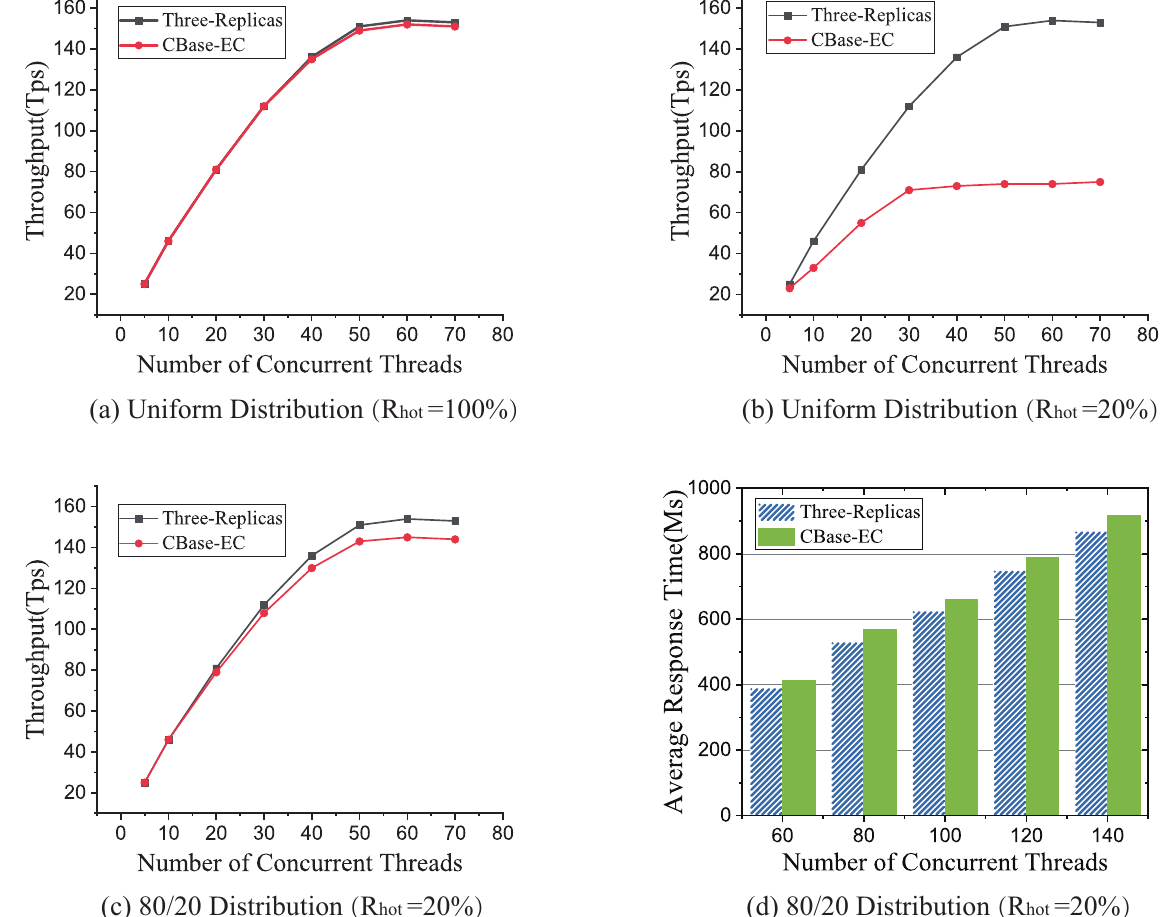
Figure 6. Comparison of Online Transaction Processing (OLTP) performance of CBase based on three-replicas and CBase-EC strategies. Uniform Distribution mean that data access requests are uniform across all tablets.The 80/20 distribution means that 80% of the data access are concentrated on 20% of the hot tablets. R hot refers to the percentage of hot data